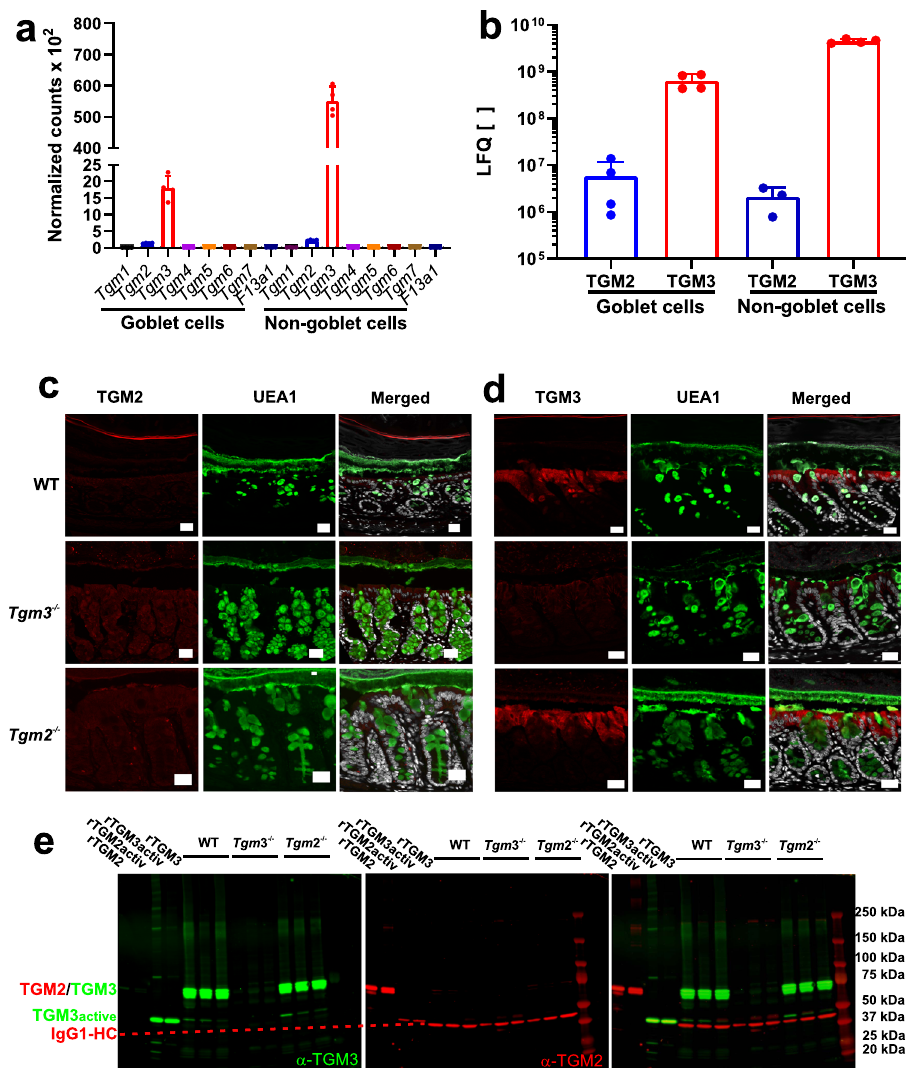
Fig. 1 mRNA expression, protein abundance and spatial localization of TGM isozymes in the large intestine. a mRNA-seq expression data of the goblet and non-goblet cell fraction. Goblet cells were separated from other epithelial cell types using FACS-mediated sorting 20 . The graph shows the normalized expression levels of the transglutaminase family members Tgm 1-7 and F13a1 . n = 4. Data are presented as mean ± standard deviation. Source data are provided as a source data fi le. b Label-free quanti fi cation of TGM isozymes 2 and 3 in goblet cell and remaining epithelial cells after FACS-mediated cell sorting from RedMUC2 98 tr T g mice 20 . The abundance of TGM2 and 3 in the two fractions was measured by mass spectrometry and the data analyzed using the MaxQuant software. n = 4. Data are presented as mean ± standard deviation. Source data are provided as a source data fi le. c Immunohistochemistry of colonic tissue specimens from C57/BL6, Tgm3 − / − and Tgm2 − / − mice suggests no TGM2 biosynthesis in the colon. The sections were probed with a monoclonal antibody against TGM2 followed by detection with a secondary antibody coupled to Alexa Fluor 647 (red). The UEA1 lectin (green) was used for goblet cell and mucus visualization. Nuclei were visualized using Sytox green (gray). Scale bar = 20 μ m. n = 3. d Analogously, confocal microscopy of colon specimen from C57/BL6, Tgm3 − / − and Tgm2 − / − mice analyzed for TGM3 (red) using a polyclonal anti-TGM3 antibody that was detected by a